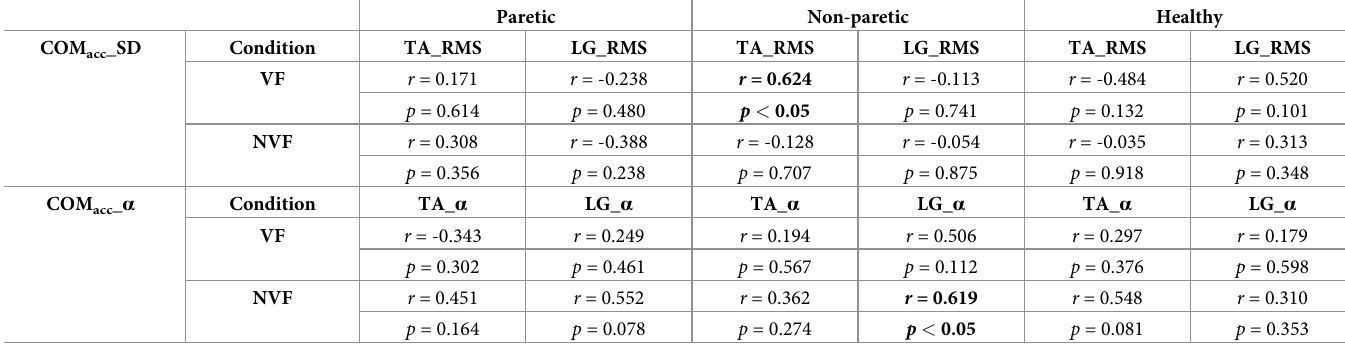
Table 3. Correlations between the COM acc and the sEMG variabilities. Paretic Non-paretic